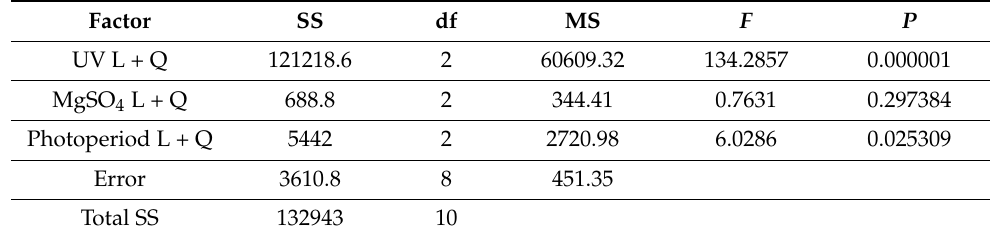
Table 4. Analysis of variance Box–Behnken design.